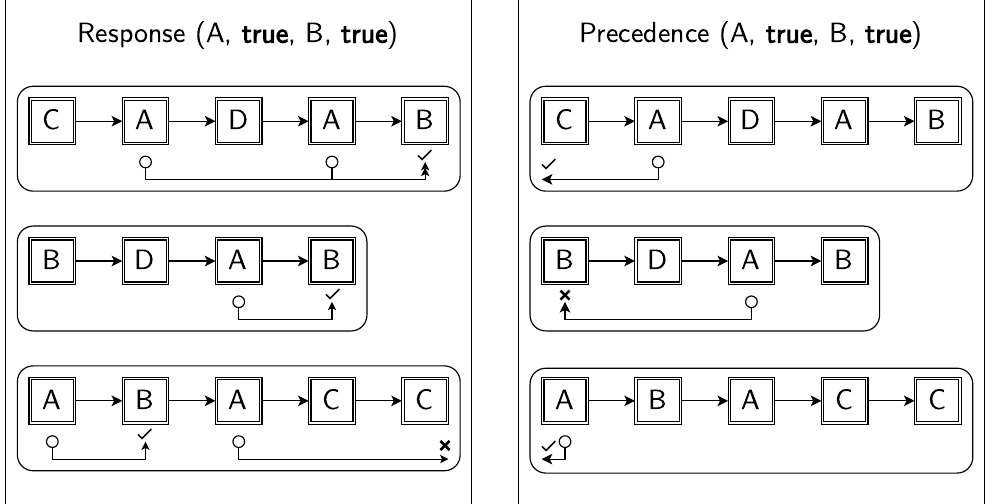
Figure 4. Two exemplifying clauses distinguishing Response and Precedence behaviours. Traces are represented as temporally ordered events associated with activity labels (boxed). Activation (or target) conditions are circled here (or ticked/crossed). Ticks (or crosses) indicate a (un)successful match of a target condition. For all activations, there must be an un-failing target condition; for precedence, we shall consider at most one activation. These conditions require the usage of multiple join tests per